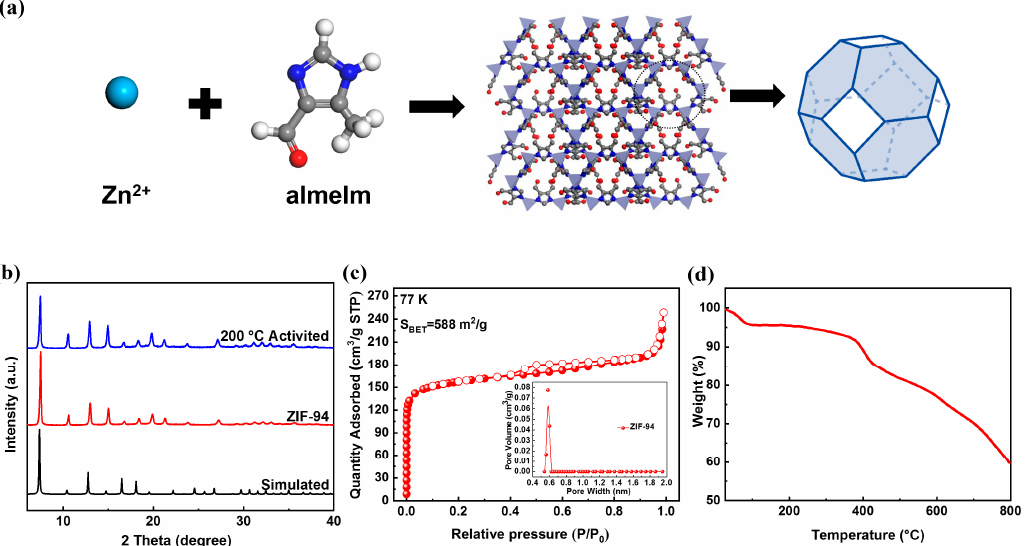
Figure 1. ( a ) The structure of ZIF-94. ( b ) The PXRD of freshly synthesized samples and activated samples. ( c ) The N 2 adsorption isotherm of ZIF-94 at 77 K. ( d ) TGA data obtained for ZIF-94.